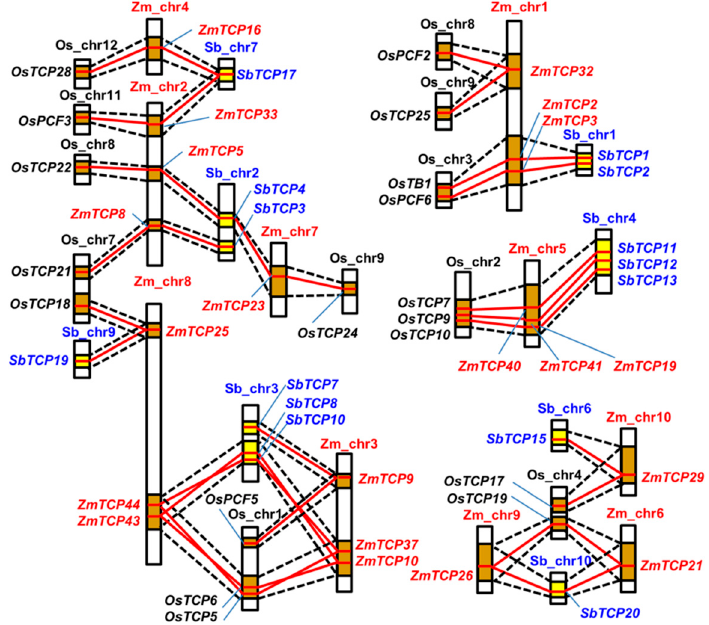
Figure 2. Schematic diagram of syntenic chromosomal segments containing ZmTCP genes between the rice, sorghum, and maize genomes. The maize, rice, and sorghum chromosomes are abbreviated Zm, Os, Sb, respectively. Homologous chromosomal regions between the different genomes are linked by black dotted lines and pale blue shaded regions. Each TCP orthologous gene pair was connected by a red line. Yellow boxes indicate homologous segments between the maize and the sorghum genomes, while the brown boxes identify the homologous regions in the maize and rice genomes.